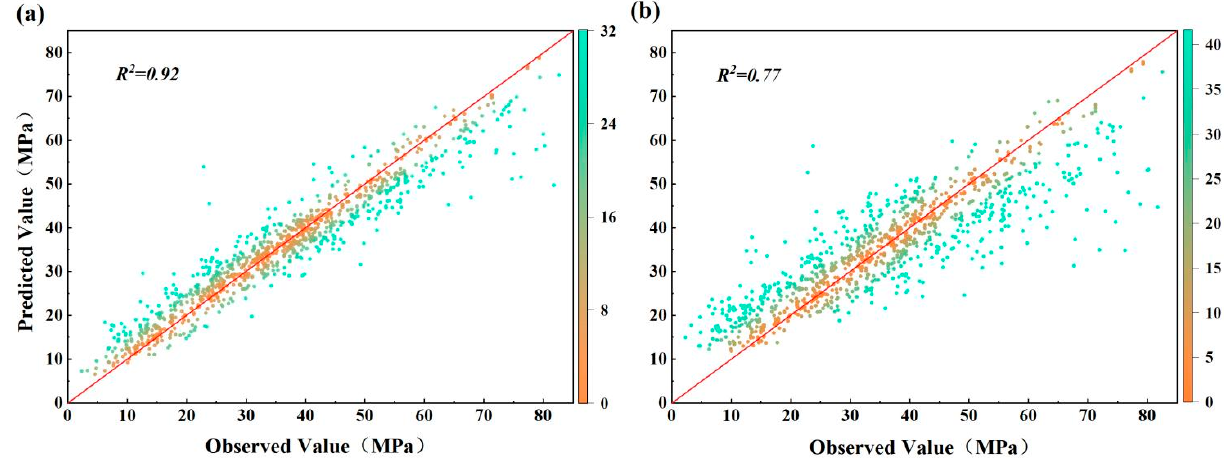
Figure 8. Comparison between observed and predicted strength values. ( a ) of dataset 1 and ( b ) of dataset 2.